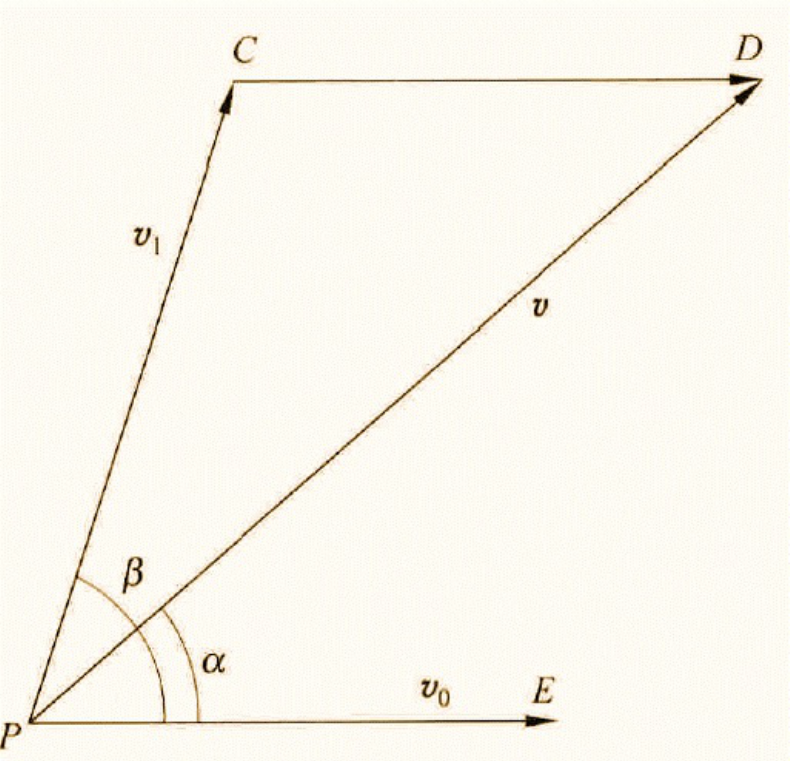
Fig. 4 Schematic diagram of each speed